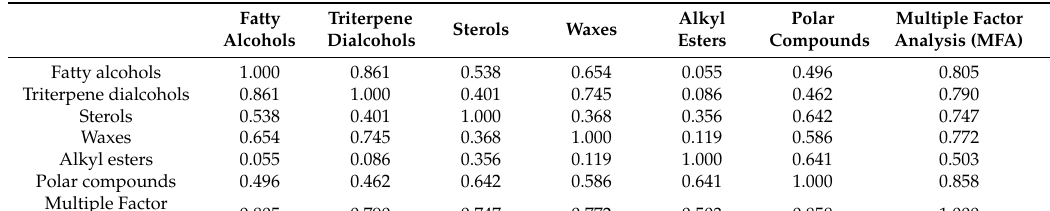
Table 2. Coe ffi cient RVs for the correlation between the di ff erent groups used for Multiple Factor Analysis (MFA) of minor compounds in the fat from green Spanish-Style Gordal table olives according to processing phases and fat extraction method.